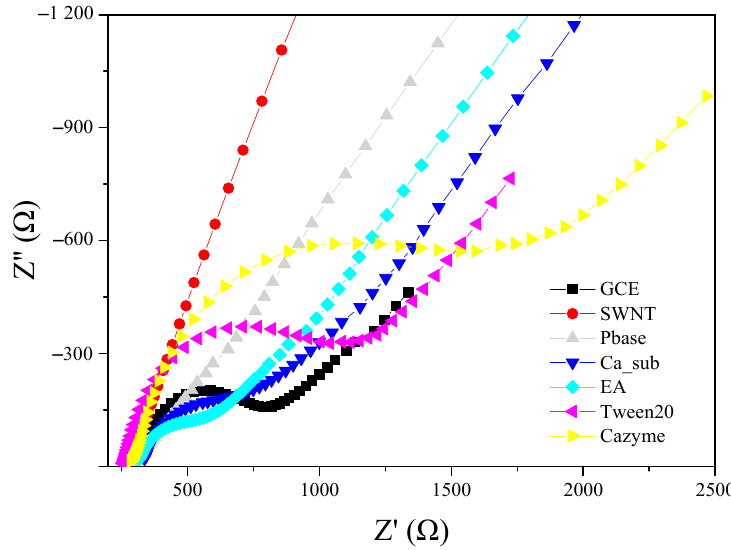
Figure 3. Electrochemical impedance spectra of GCE modified successively with SWNTs, PBASE, Ca_sub, EA, Tween 20, and CAZyme obtained at frequencies ranging from 1 to 10 5 Hz (potential = 0.2 V) in 5 mmol/L [Fe(CN) 6 ] 3 − /4 − and 0.1 mol/L KCl.